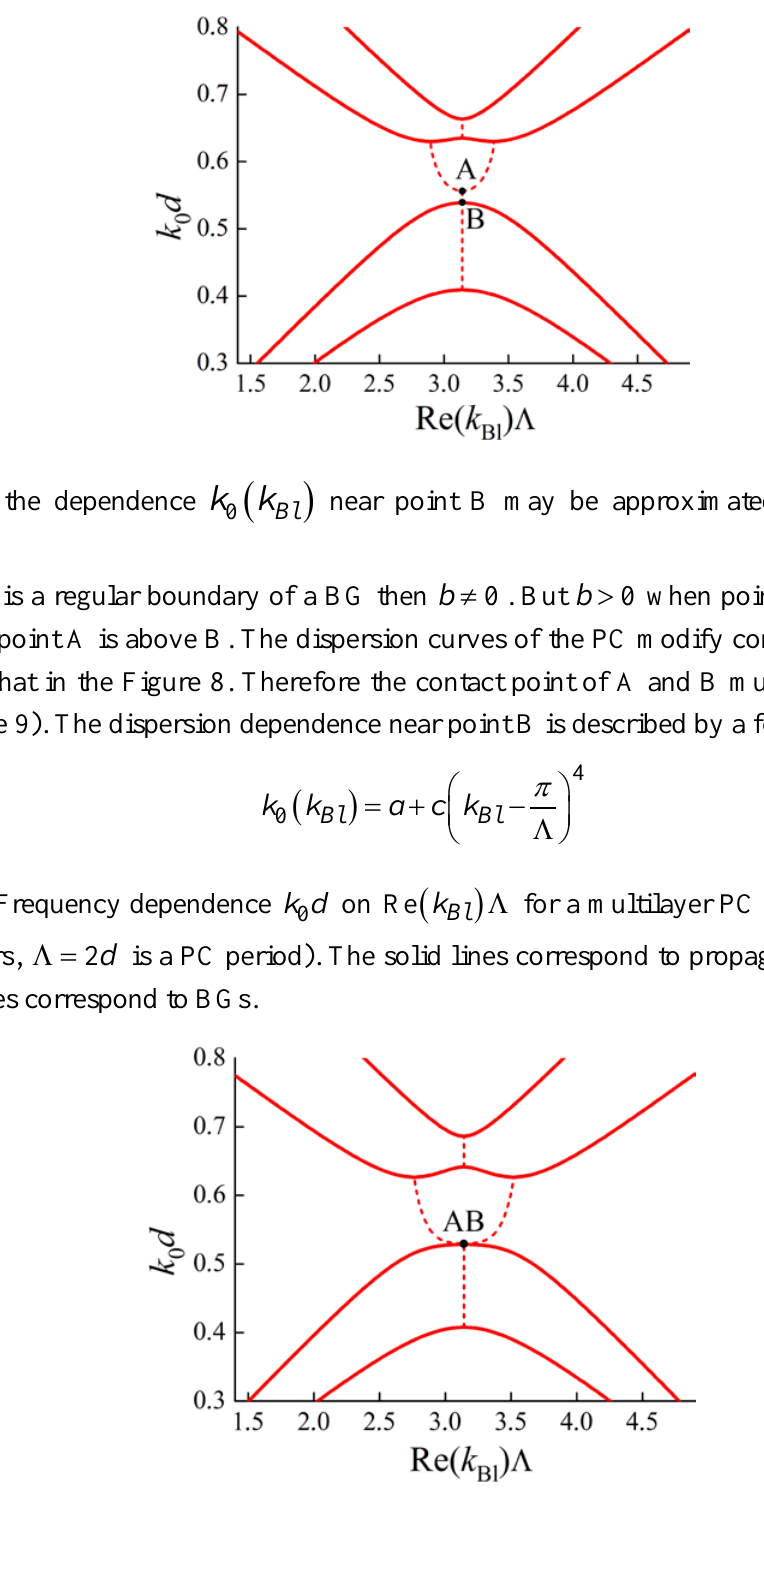
π = (see Figure 8). k Bl Λ k Λ for a multilayer PC ( d —thicknesses k d on ( ) Re Bl 0